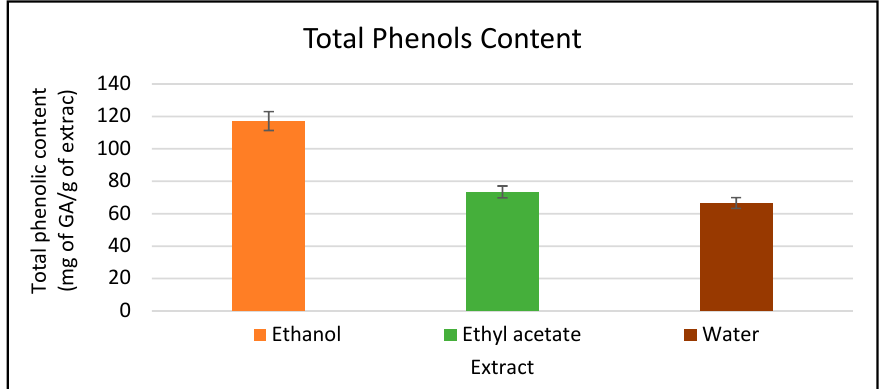
Figure 1. Total phenolic content in mg GAE/g dry weight of A. citrodora extracts. Results are expressed as means of three independent experiments (bars) ± SEM (lines).